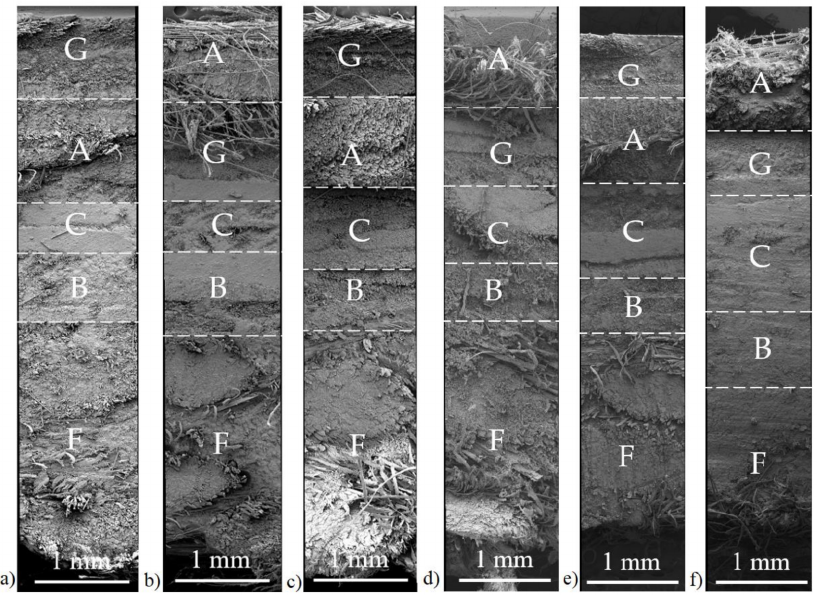
Figure 1. SEM images of cross sections of hybrid composites: H-GACBF ( a ), H-AGCBF ( b ), V-GACBF ( c ), V-AGCBF ( d ), I-GACBF ( e ), I-AGCBF ( f